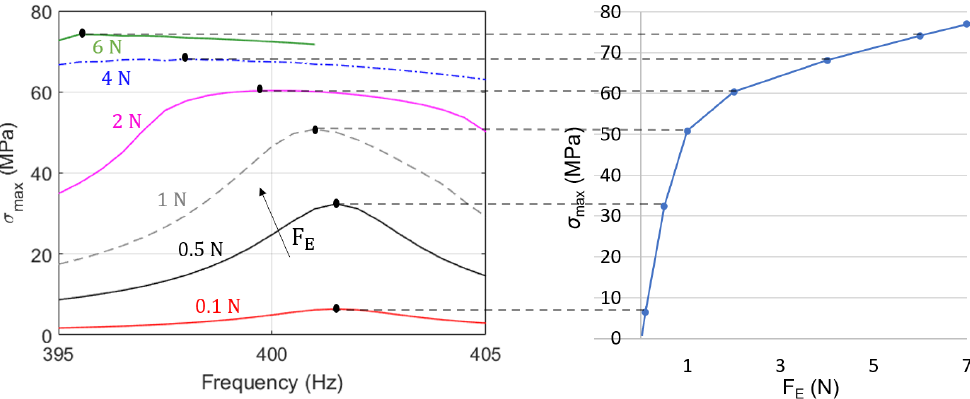
Figure 4. ( Left ) Maximum bending stress on the blade (at airfoil root) as a function of frequency. Different excitation levels are explored | F E | = [ 0.1,6 ] N. ( Right ) Maximum bending stress vs. F E